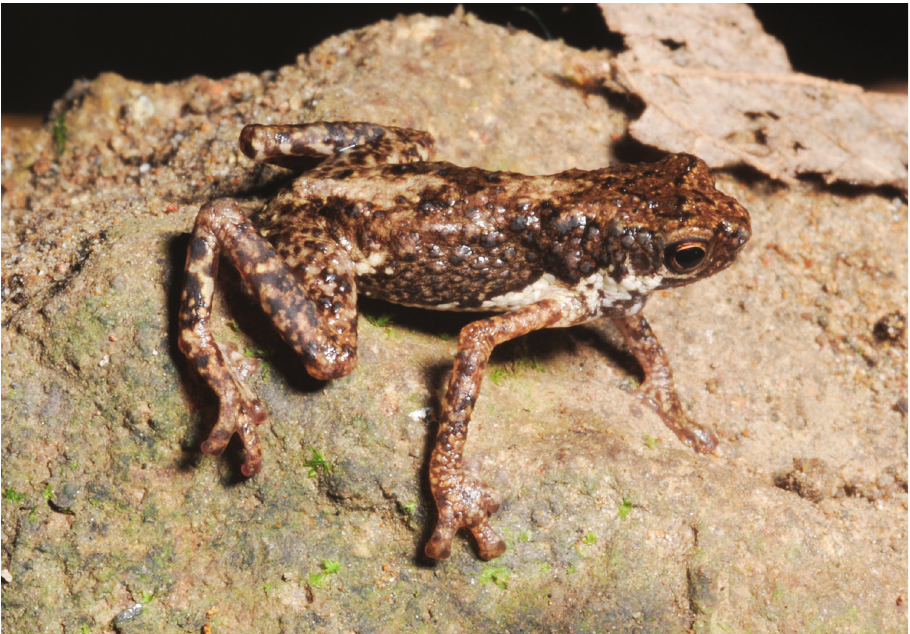
Figure 3. Pelophryne brevipes male (KU 334658) from 1200 masl, Shrine Site, Municipality of Gingoog, Mt. Lumot, Misamis Oriental Province. Photo: